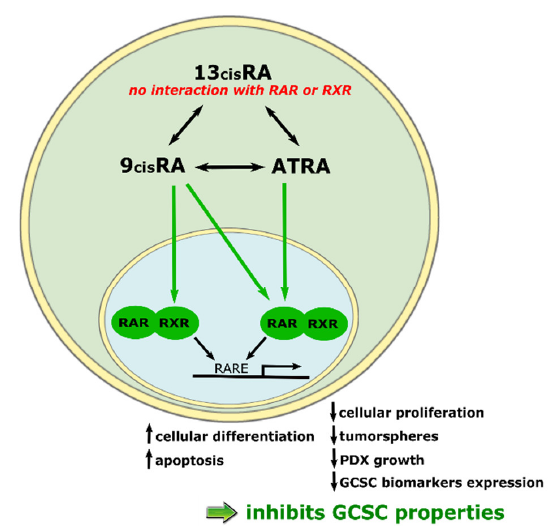
Figure 4. Schematic representation of ATRA’s signaling pathway and anticancer effects. double black arrows: possible isomerization between these two molecules; green arrows: isomer’s ability to bind RAR or RXR receptor; simple black arrow: RAR or RXR’s ability to bind RARE.